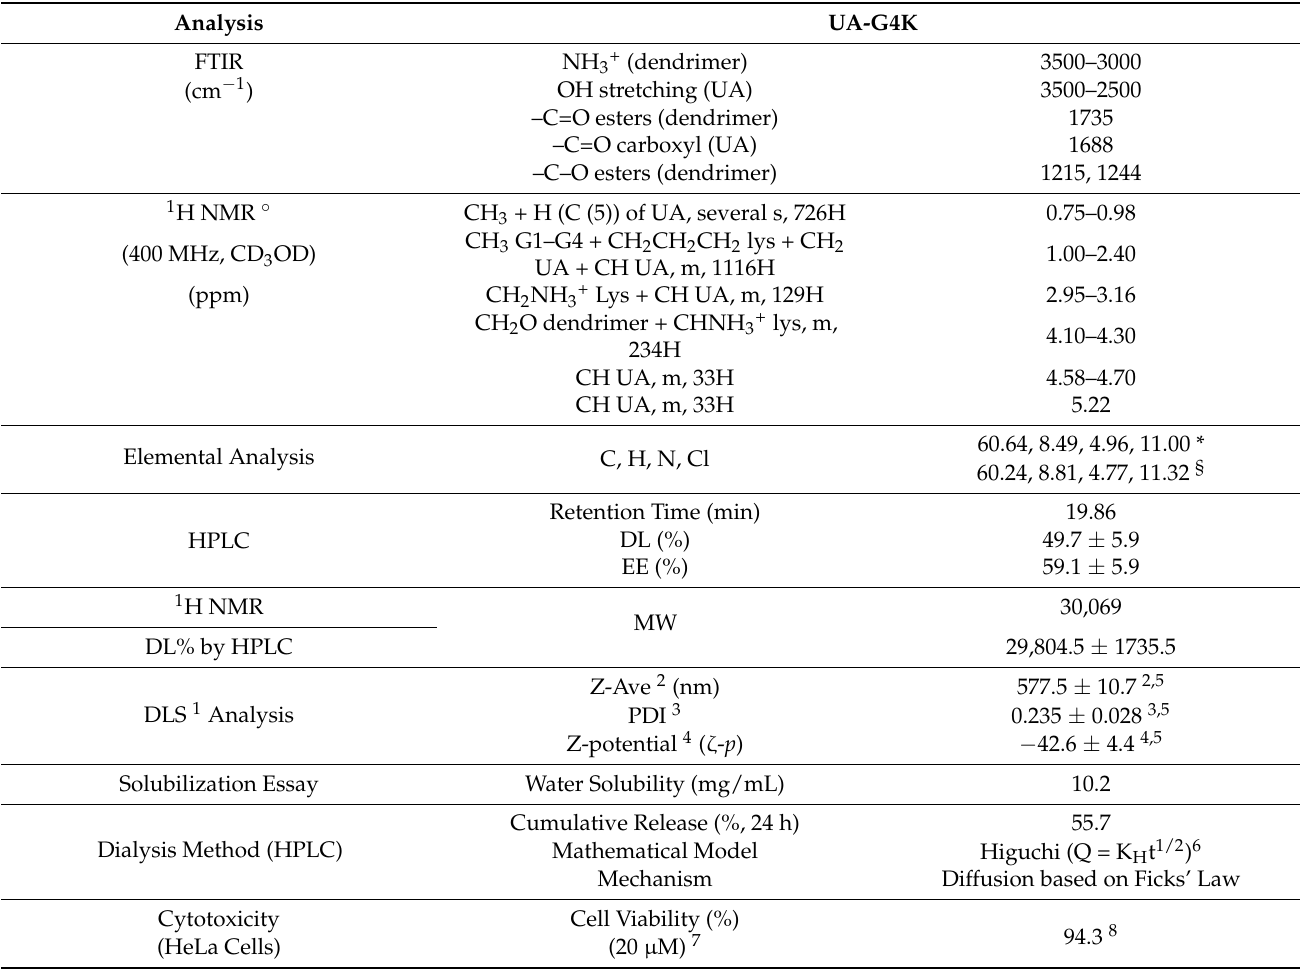
Table 1. Main characteristic of UA-G4K